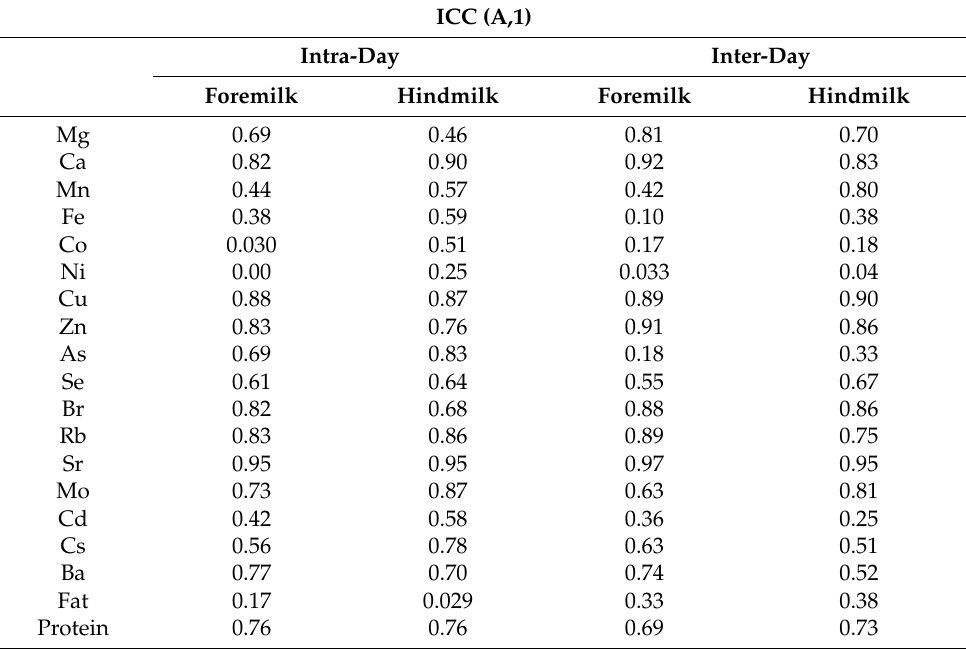
Table 8. ICCs of elements, fat, and protein in breast